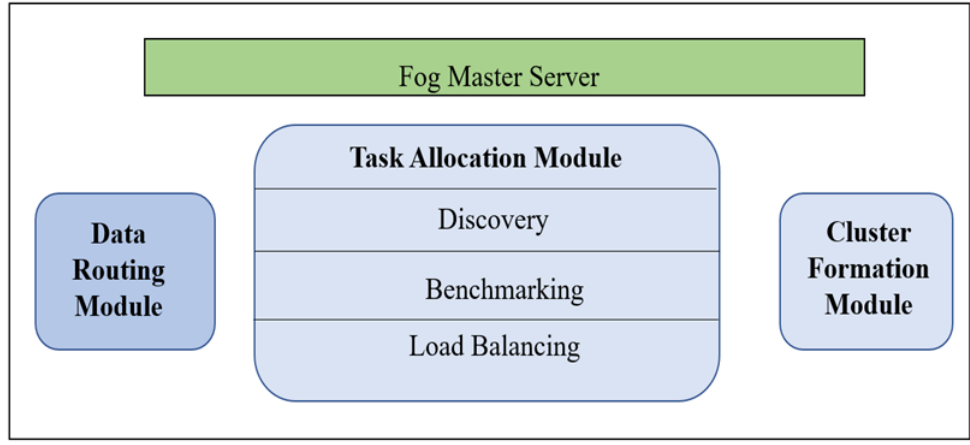
Figure 7. Modules in the Fog Master Server .